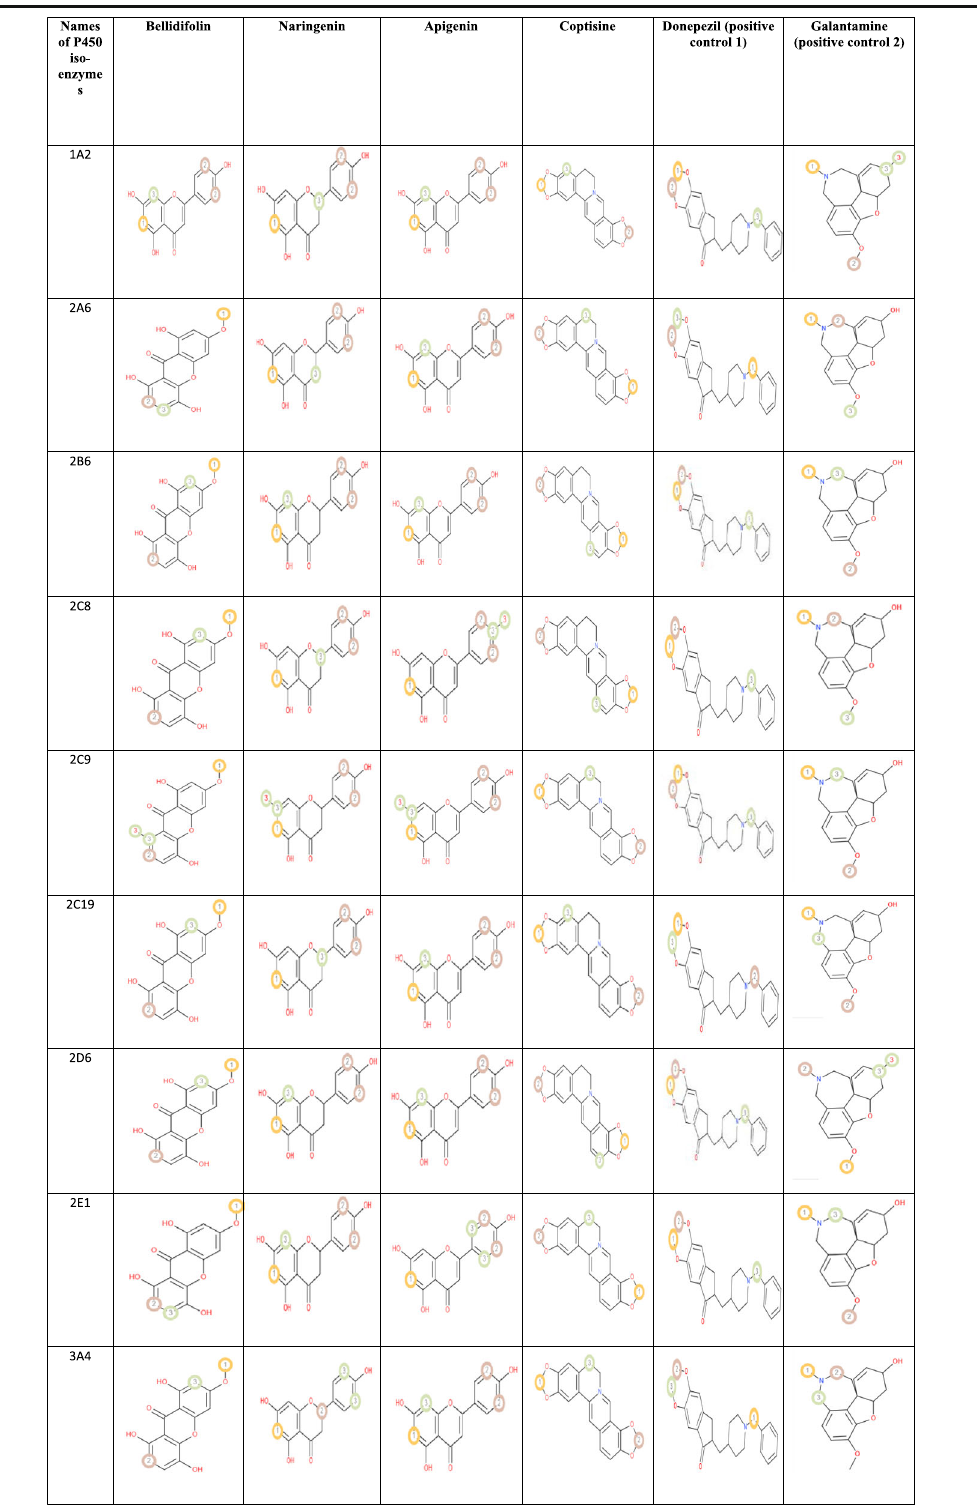
Table 8 The P450 site of metabolism prediction of the best four ligand molecules and the positive